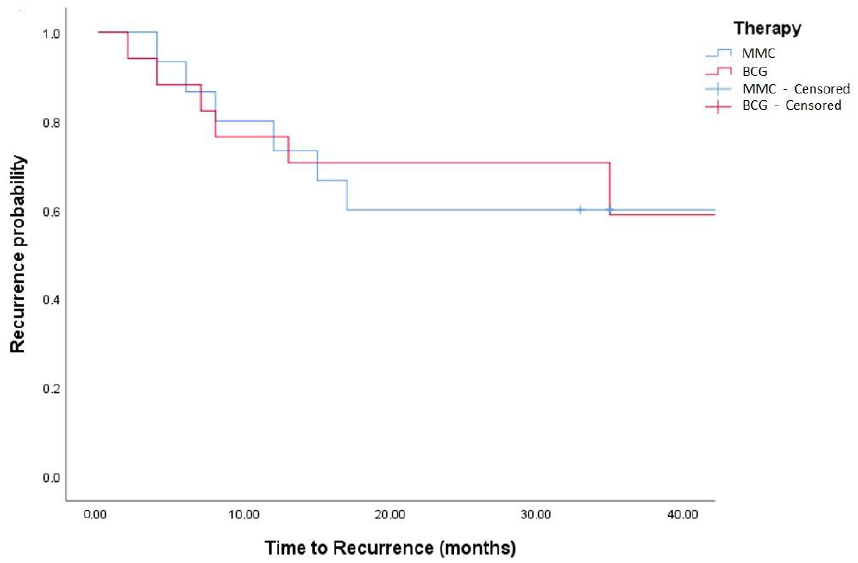
Figure 4. Kaplan – Meier in TCC+SCC patients (log-rank, p = 0.759). Figure 4. Kaplan–Meier in TCC + SCC patients (log-rank, p =